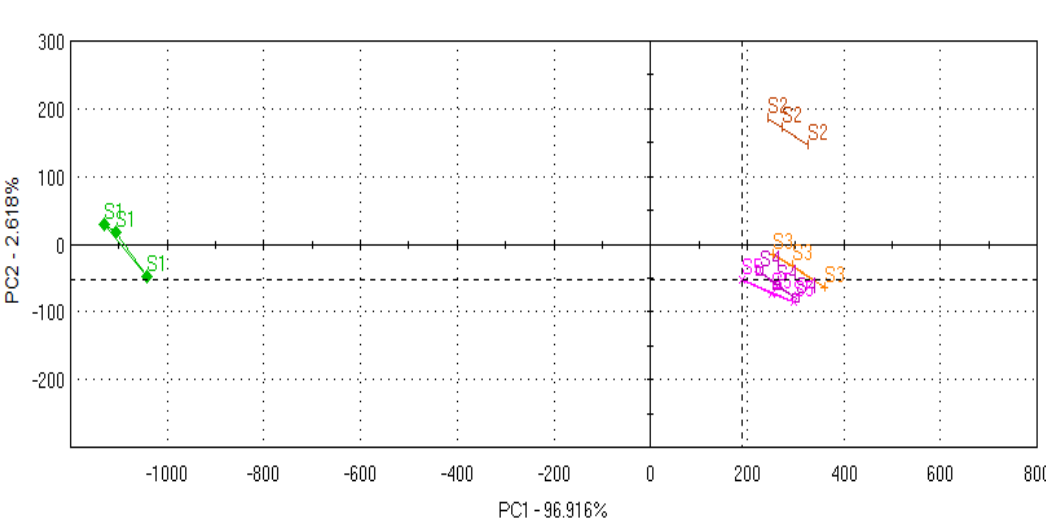
Figure 4. Taste map of formulations based on principal component analysis (PCA) of sample 1 (S1), sample 2 (S2), sample 3 (S3), sample 4 (S4) and sample 5 (S5). S1: Xylocaine ® , S2: Xylocaine ® + 0.338% CTE + 0.09% sodium saccharine, S3: Xylocaine ® + 0.184% CTE + 0.09% sodium saccharine, S4: Xylocaine ® + 0.414% RAS + 0.09% sodium saccharine, S5: Xylocaine ® + 0.237% RAS + 0.09% sodium saccharine.